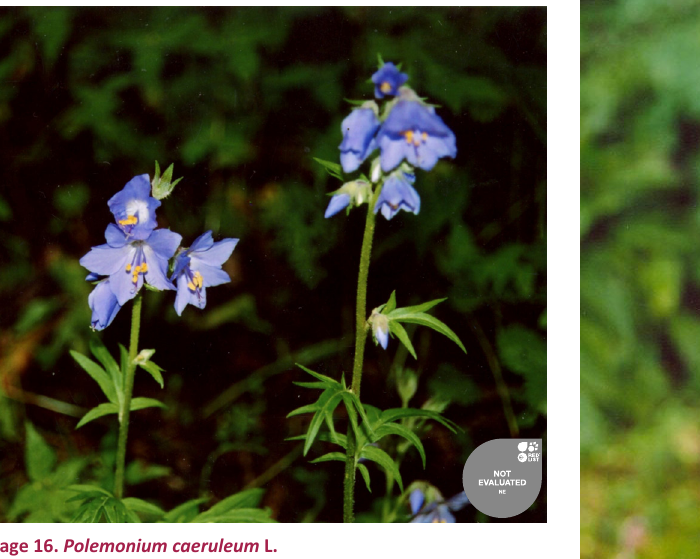
Image 16. Polemonium caeruleum L.